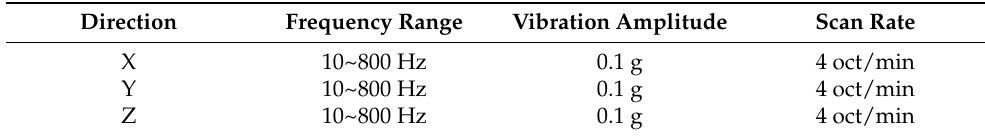
Figure 12. Frequency response tests of the SVIP prototype. Table 5. Test conditions of frequency response excitation.